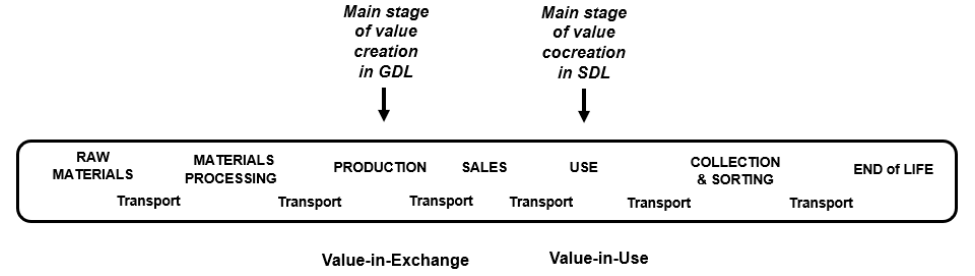
Fig. 1. Generic value chain - Comparison between value creation in GDL and cocreation in SDL . Source: Author’s